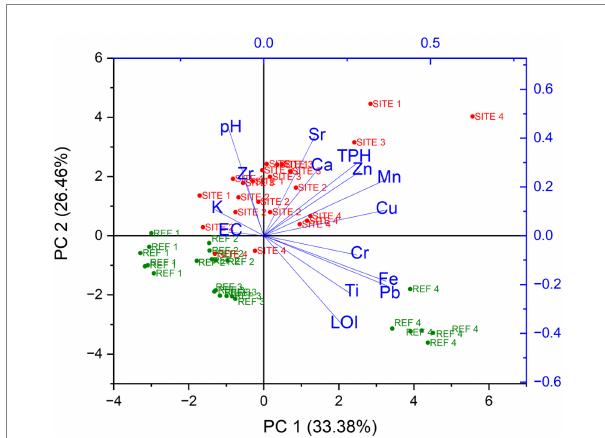
FIGURE 4 Principal Component Analysis of sediment chemical composition across the four study sites. Individual samples shown as points (red points: underpasses; green points: reference sites). Eigenvectors in blue show key characteristics of sample stations and inter- relationships between variables (where they plot in a similar direction and extent, variables are positively correlated). Based on scree analysis, there are three significant components accounting for a cumulative variance of 75.2% in the data.